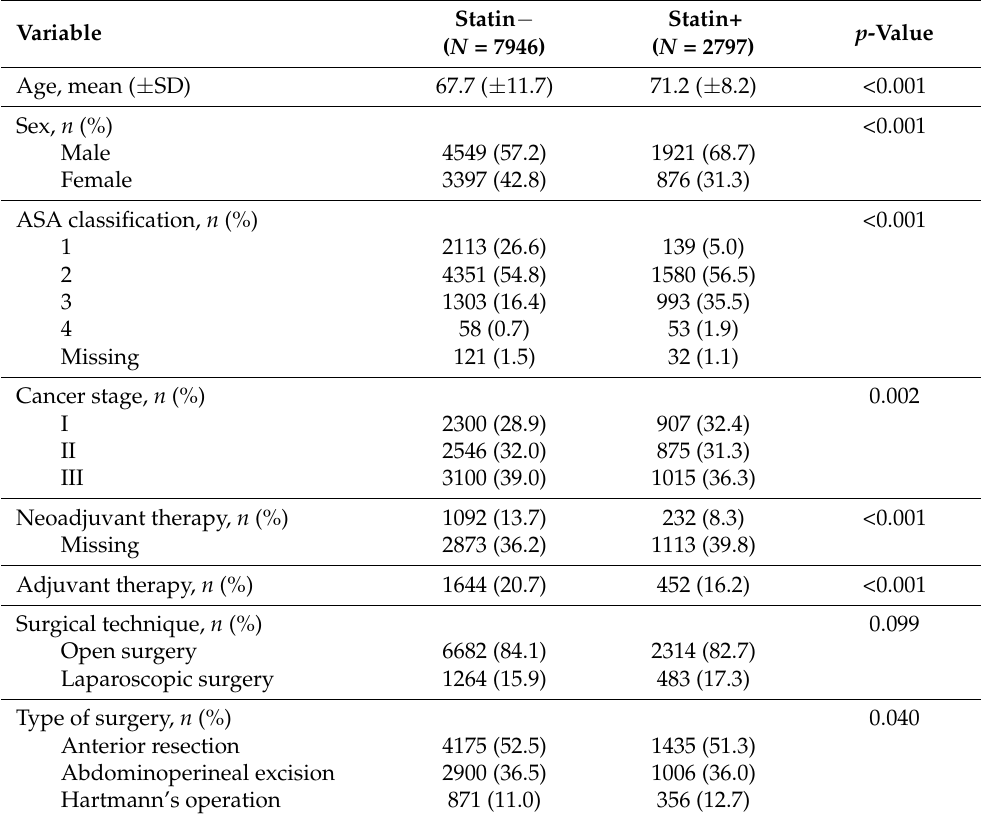
Table 1. Patient demographics and clinical features on the day of surgery.